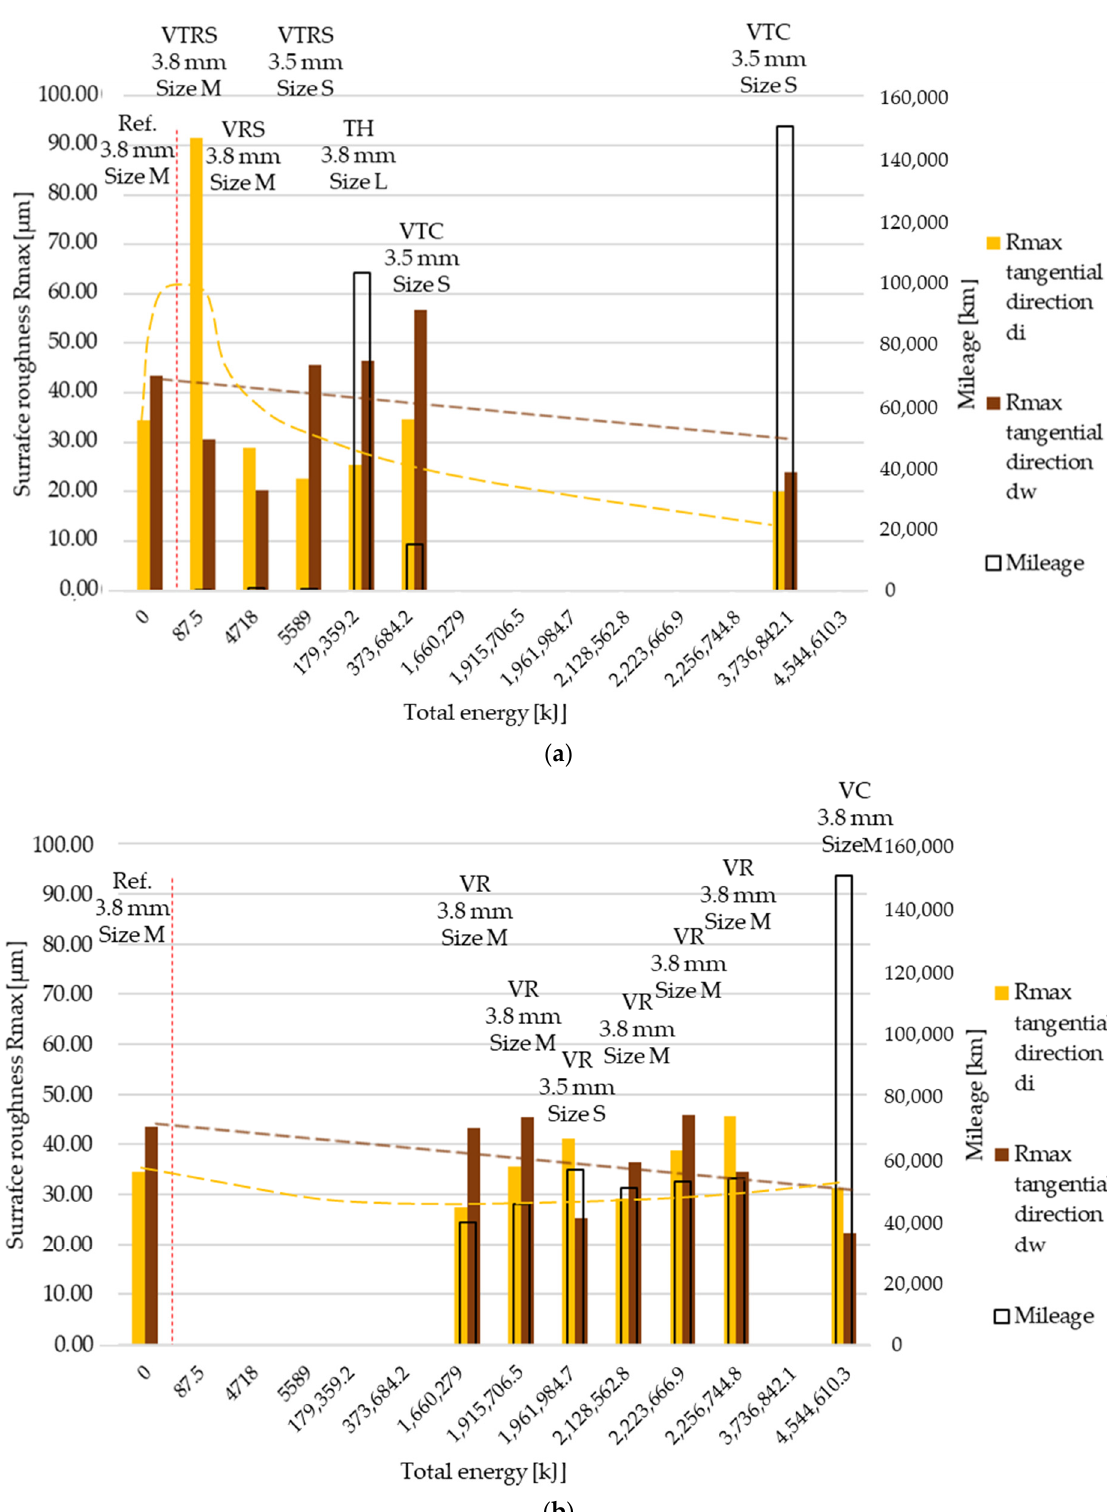
Figure 10. ( a ) Rmax surface roughness values, tangential direction–trend 1: clutch killer tests. ( b ) Rmax surface roughness values, tangential direction–trend 2: moderate tests.